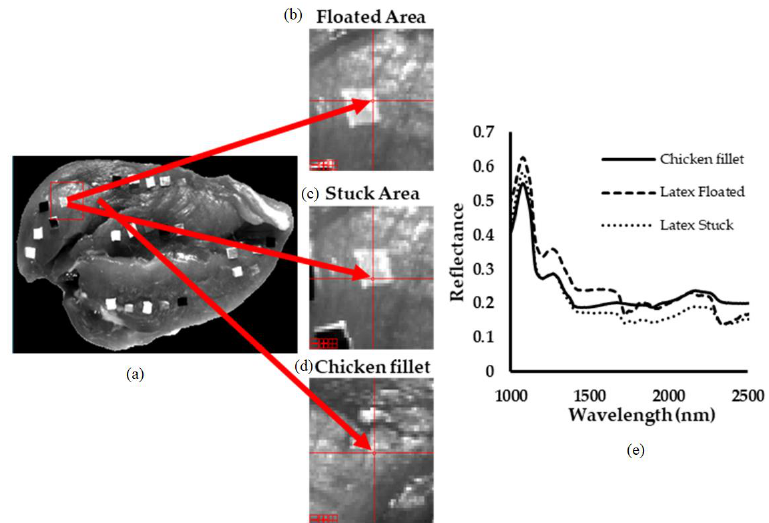
Figure 5. ( a ) A SWIR band image of a chicken breast fillet contaminated with a semi-transparent foreign material in a red box and other foreign materials; Enlarged images of a